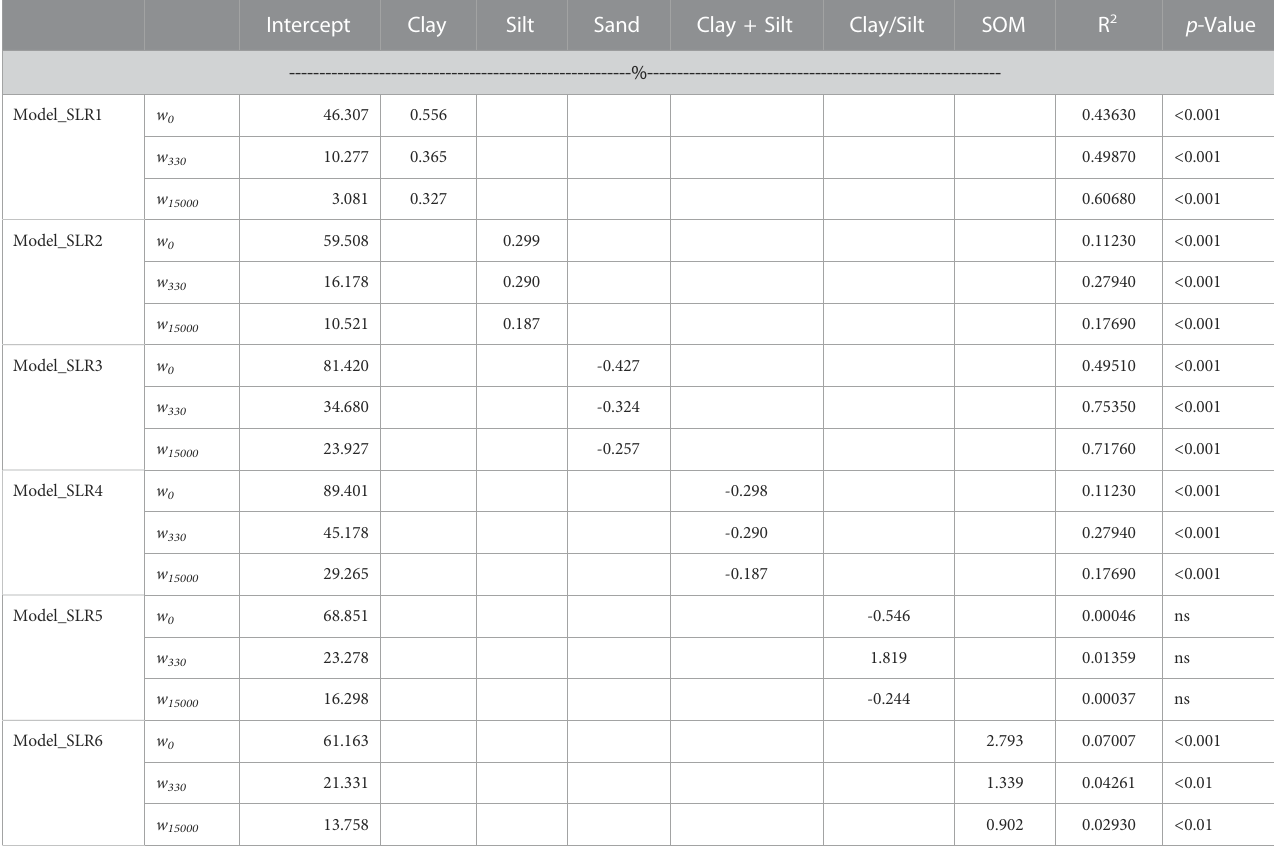
TABLE 5 Pedotransfer functions parameters using simple linear regression.